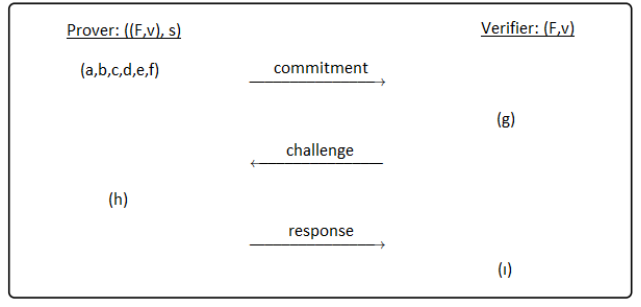
Figure 1. A 3-pass identification scheme